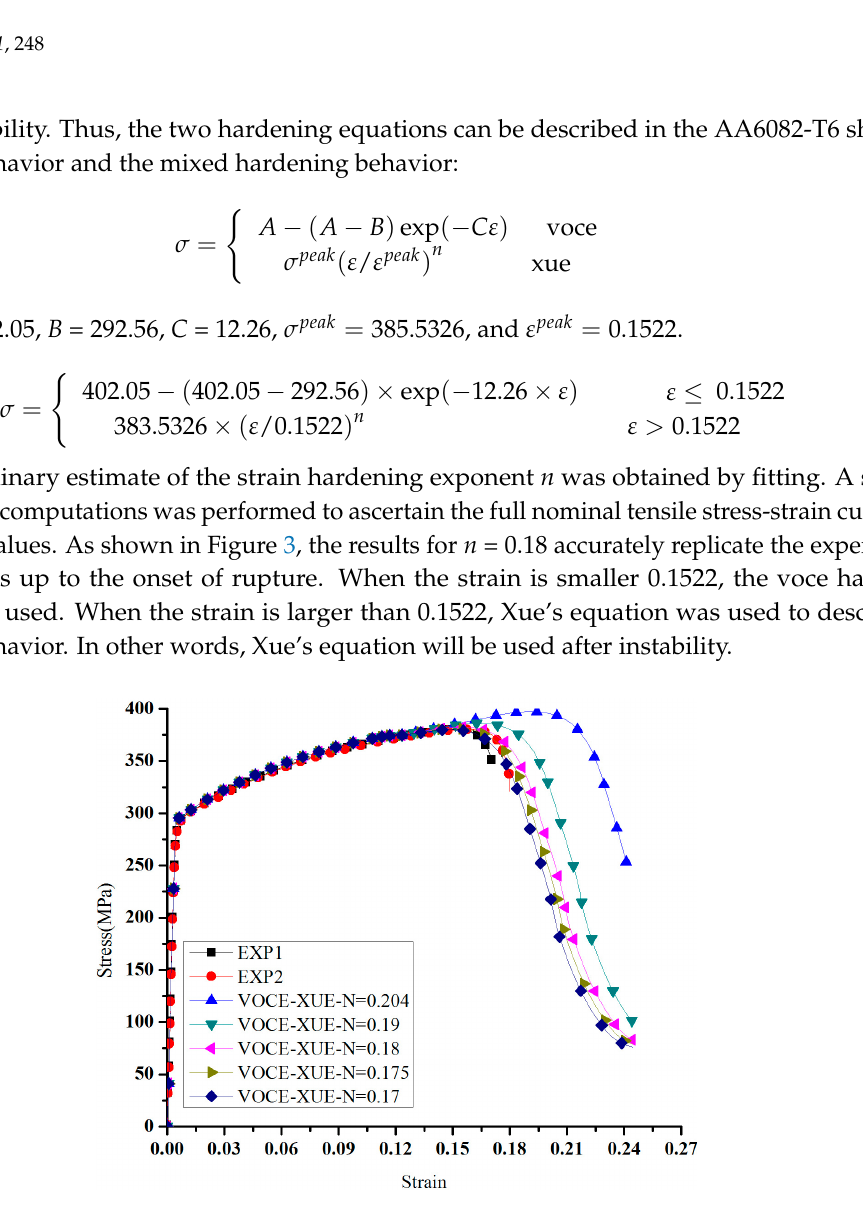
Figure 3. The hardening behavior for VOCE-XUE.